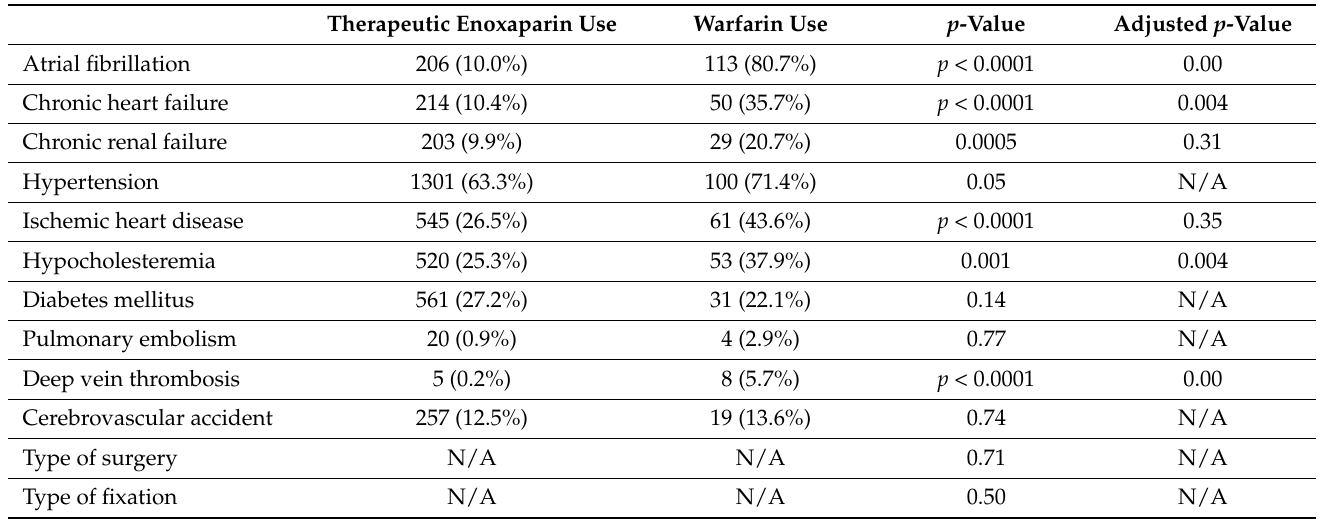
Table 1. Risk factors for anticoagulant use between cohorts. Therapeutic Enoxaparin Use